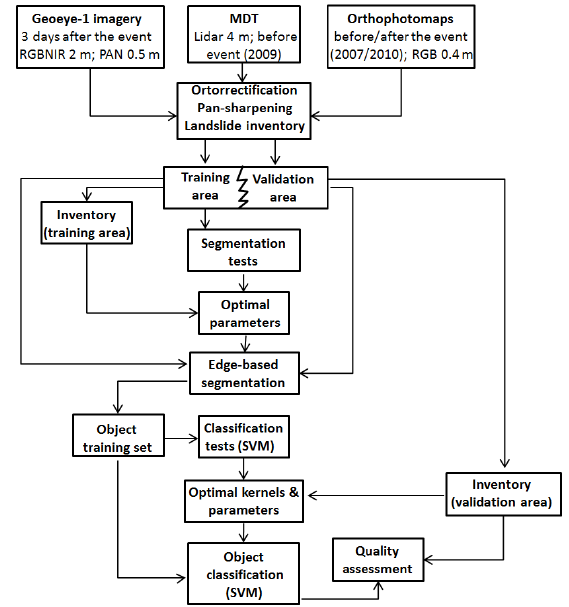
Figure 3. Diagram of the landslide mapping